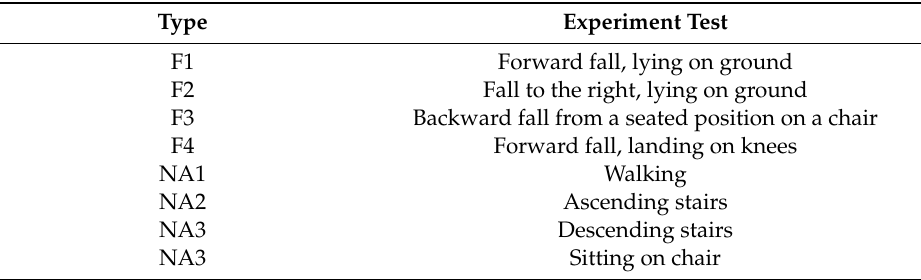
Table 2. Experiments for four kinds of fall and four kinds of normal activities.